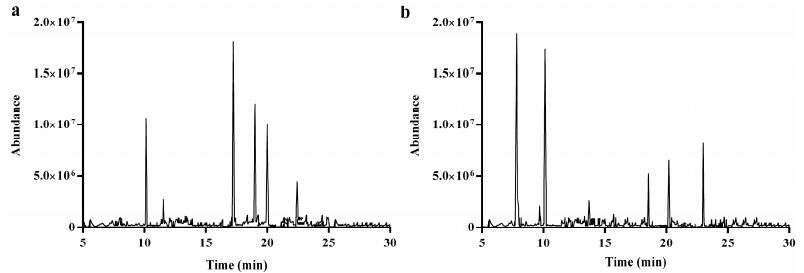
Figure 4. Total ion chromatograms (TICs) of DRP1 ( a ) and DRP2 ( b )